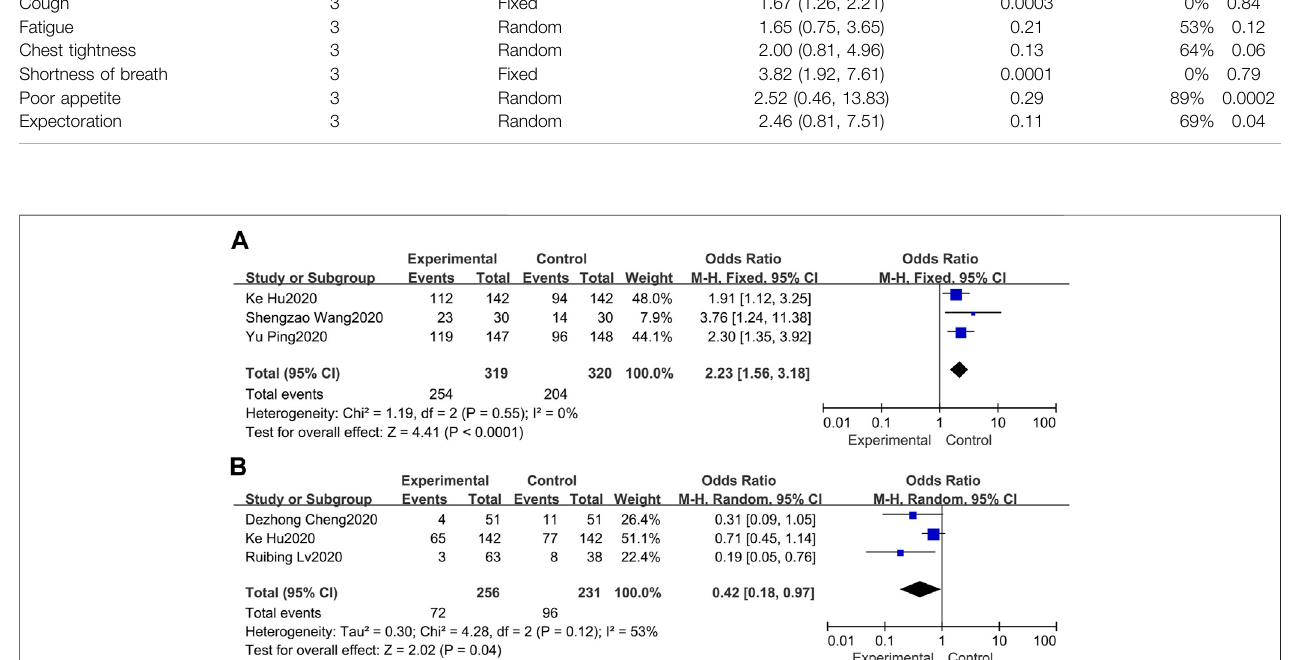
FIGURE 3 | Forest plots of the pooled results of the meta-analysis for total ef fi cacy (A) and adverse events (B) .